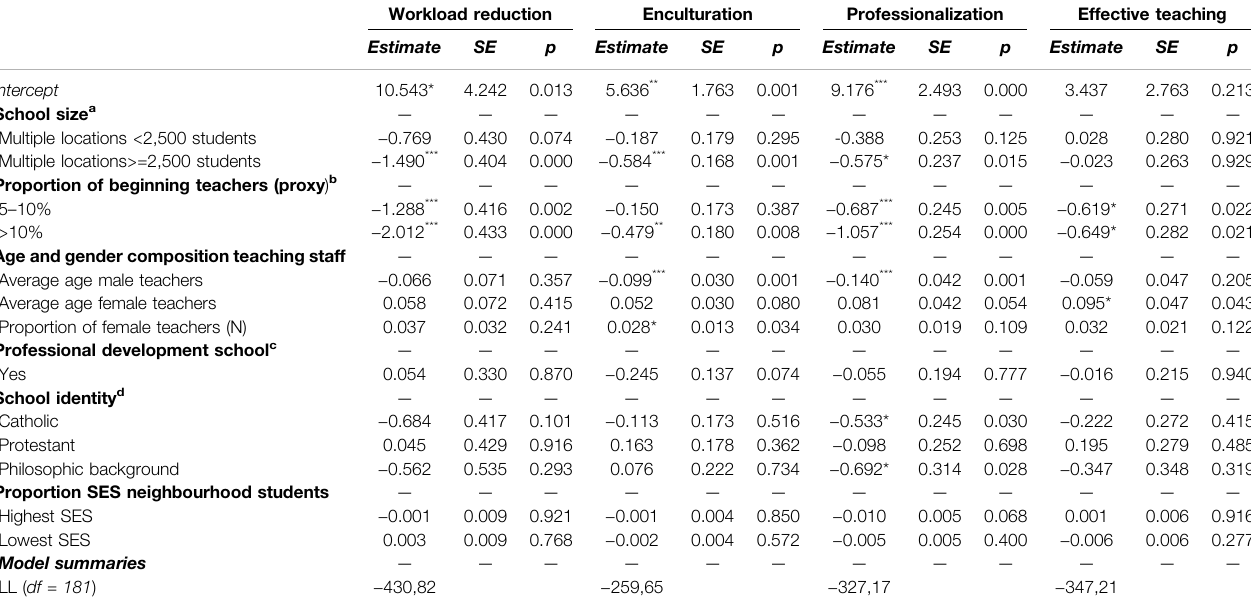
TABLE 3 | Linear regression models: reported support activities by BTs and school characteristics, four induction elements, full sample (N (cid:1) 195). Workload reduction Enculturation Professionalization Effective teaching Estimate Intercept Multiple locations < 2,500 students